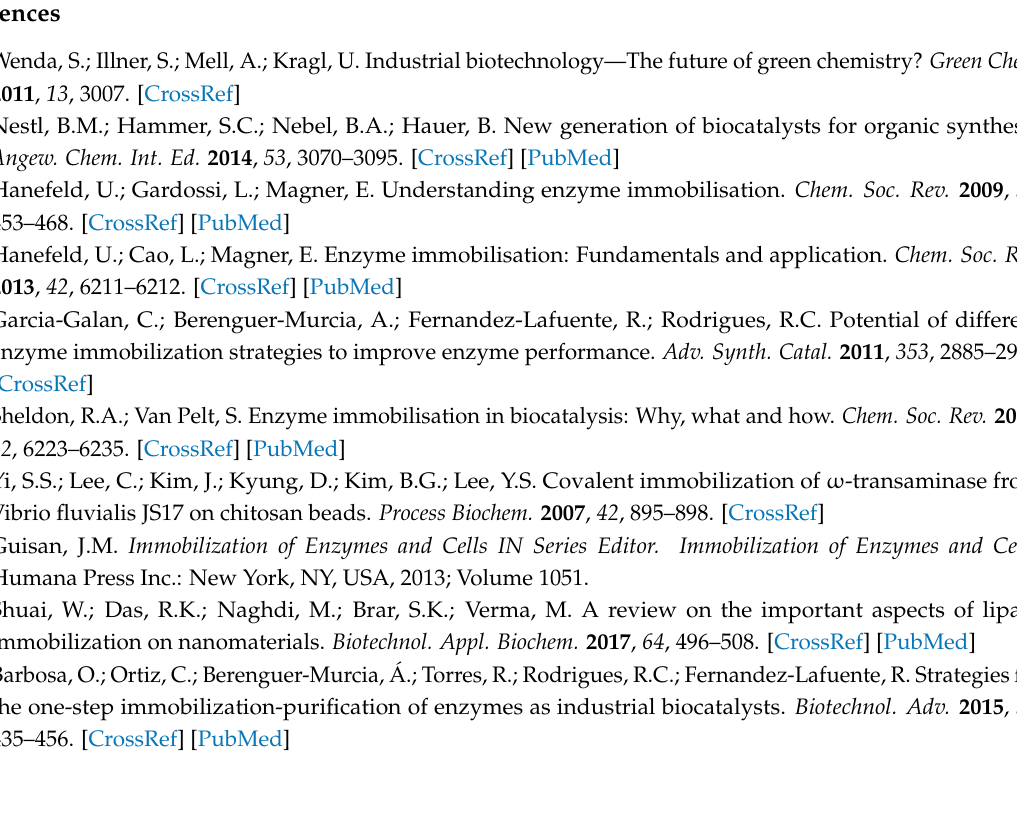
Figure S1: SDS-gel (12%) electrophoresis of T4L-HEWTs, Figure S2: HEWTs immobilisation at different incubation times, Figure S3: Reusability profile of the immobilised T4L-HEWT_L1 (circle) and T4L-HEWT_L2 (square) after 10 reaction cycles, Figure S4: Stability of HEWTs in different organic co-solvent, Table S1: computed molecular weight (MW) and molar extinction coefficients ( ε ), Figure S5: SDS-gel (12%) electrophoresis of T4L-BS2ms, Figure S6: SDS-gel (12%) electrophoresis of